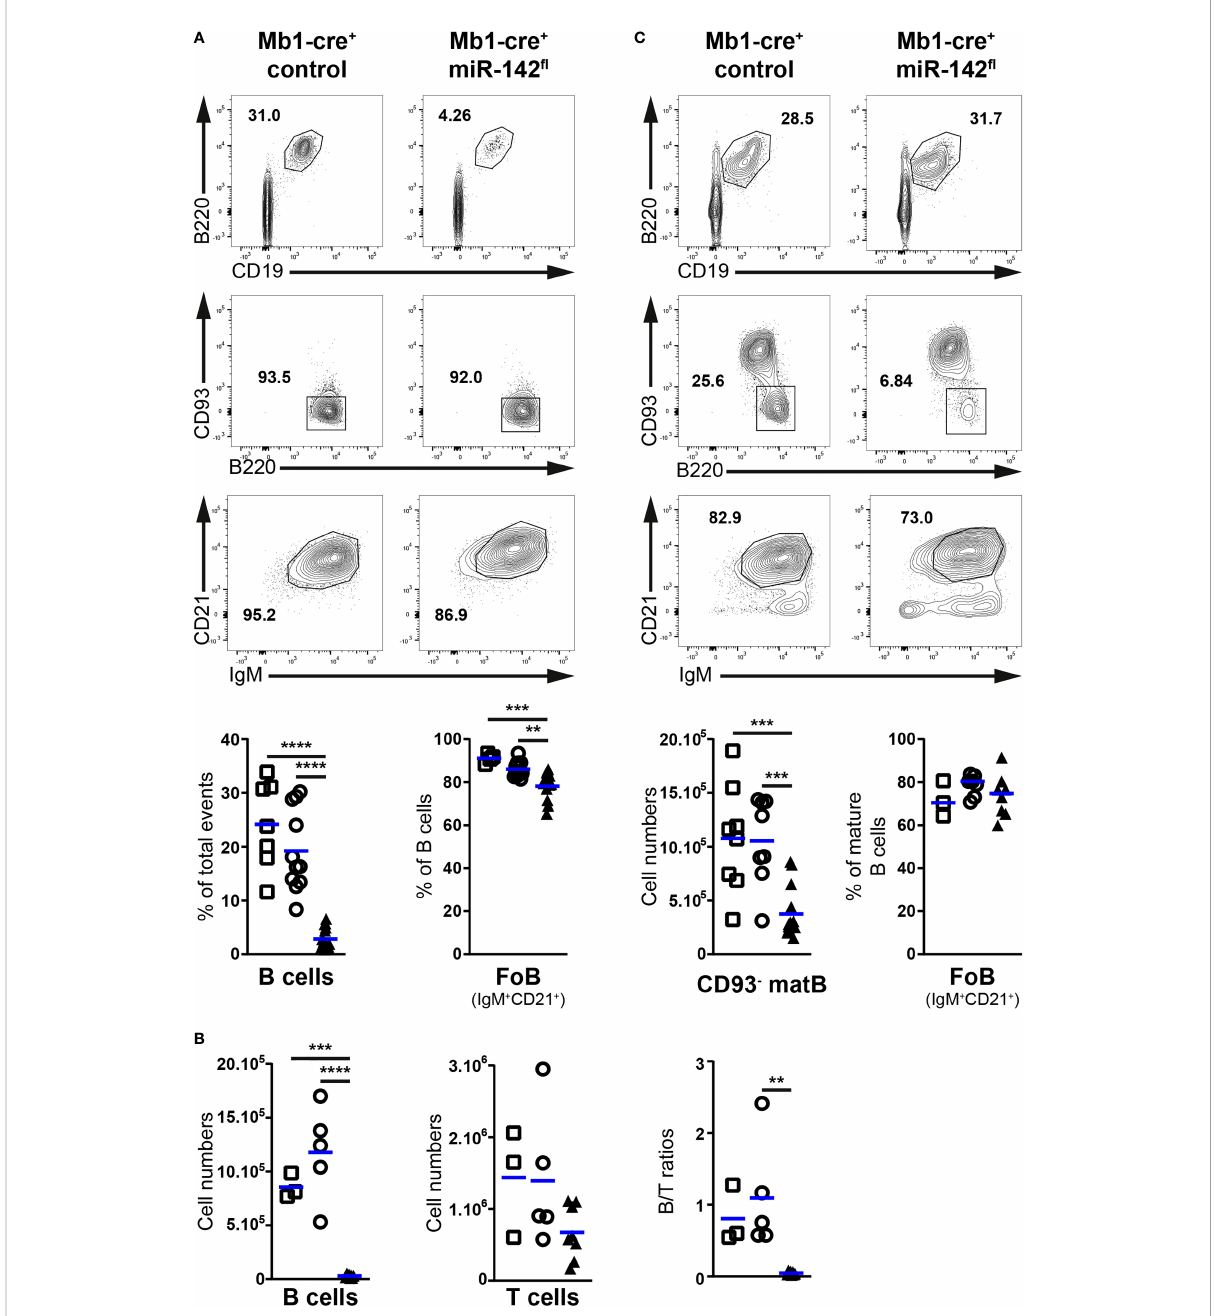
FIGURE 3 Paucity of follicular B cells in the lymph nodes and bone marrow of Mb1-cre + miR-142 fl mice. (A) Top: Flow cytometry of IgM + CD21 + follicular B cells within mature CD19 + B220 + CD93 – B cells in the lymph nodes (LNs) of Mb1-cre + control and Mb1-cre + miR-142 fl mice. Bottom: Proportions of B cells in LNs and follicular (FoB) B cells within LN B cells of Mb1-cre – ( □ ), Mb1-cre + ( ○ ) and Mb1-cre + miR-142 fl ( ▲ ) mice. n = 4-16 per group, cumulative of 14-17 independent experiments. (B) (Left) CD19 + B cell and CD5 + T cell numbers, and (right) B/T ratios (% CD19 + / % CD5 + cells within lymphocyte gates), in the inguinal LNs of control and mutant mice, as de fi ned in (A) . n = 3-8 per group, cumulative of 8 independent experiments. (C) Top: FACS analysis of IgM + CD21 + CD19 + B220 + CD93 – mature follicular B cells in the bone marrow of Mb1-cre + and Mb1-cre + miR-142 fl animals. Bottom: mature B cell numbers (CD93 – matB) and frequency of follicular B cells within mature B cells in the bone marrow of Mb1-cre – ( □ ), Mb1-cre + ( ○ ) and Mb1-cre + miR-142 fl ( ▲ ) mice. n = 3-14 per group, from 9-15 independent experiments. (A – C) Each symbol indicates one mouse. Horizontal blue lines signify the means. **, P ≤ 0.01; ***, P ≤ 0.001; ****, P ≤ 0.0001 by one-way